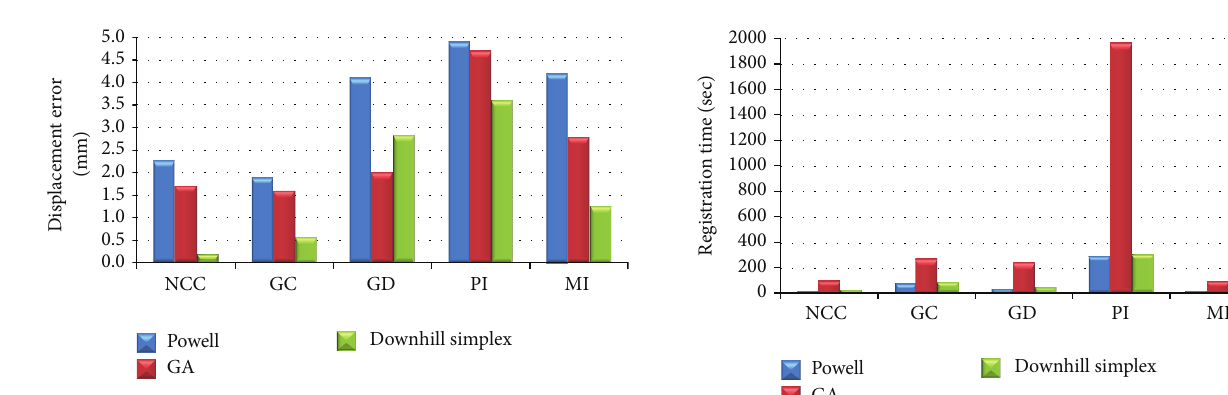
Figure 12: Displacement errors (mm) of fifteen combinations.